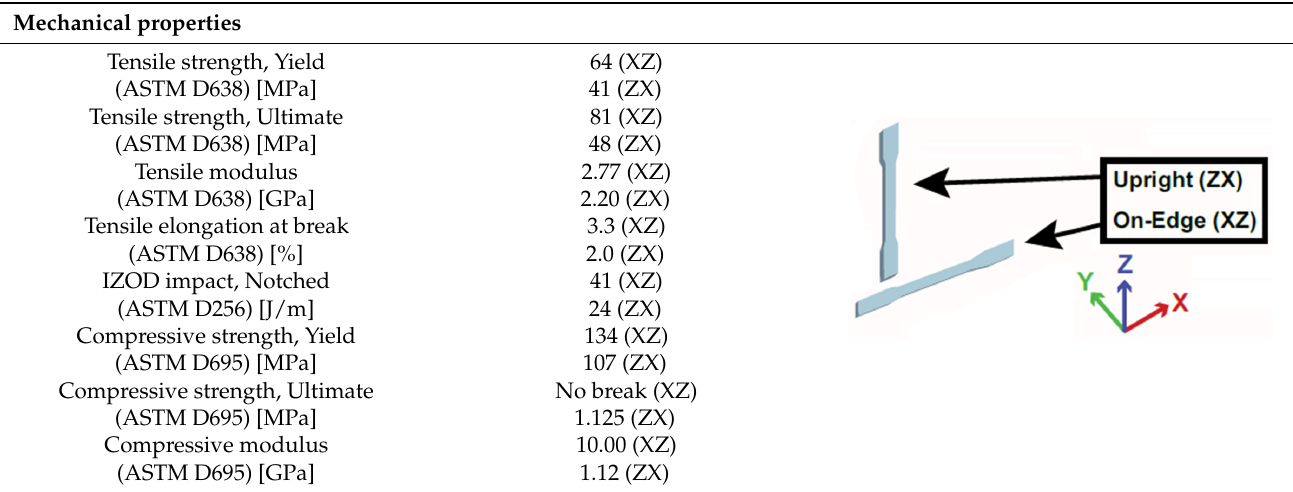
Table 1. Main properties of ULTEM 1010 [10].